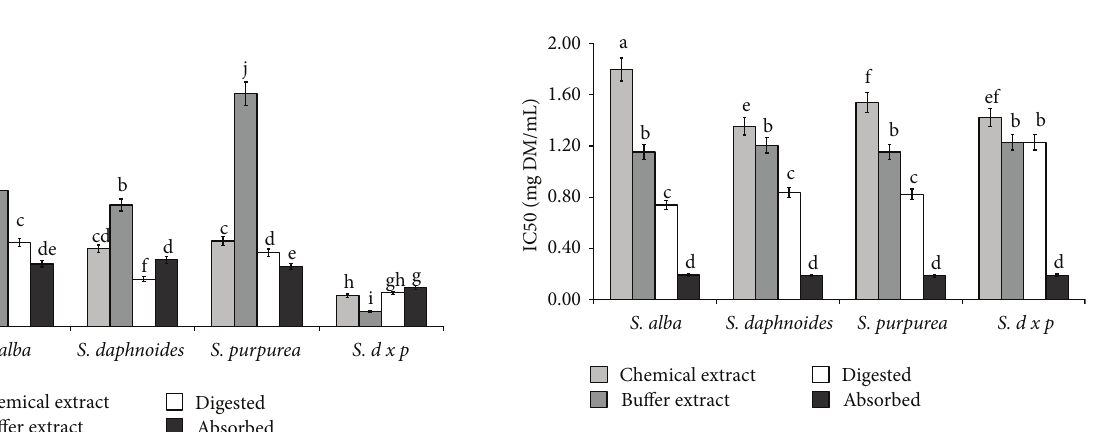
Figure 3: Effect of extraction system on chelating power of phy- tochemicals from bark of different Salix genotype. Bars (means) followed by the different letters differ significantly (Tukey-test, 𝑃 < 0.05 ).